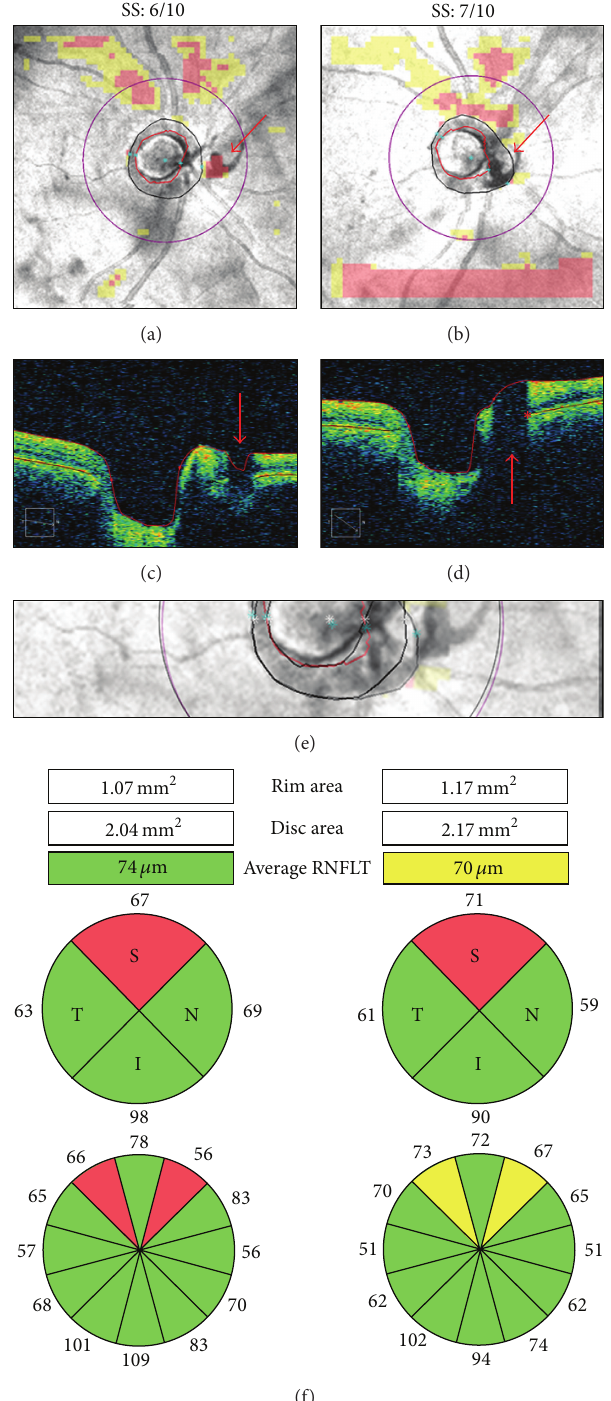
Figure 3: Floater overlying the optic disc region. Cirrus HD-OCT RNFL deviation maps ((a)-(b)), OCT tomograms ((c)-(d)), realigned en- face images (e), and printout results (f) from two right optic disc scans collected on the same day. In the first scan, the floater was located between the optic disc and the scan circle ((a) and (c), arrow). In the second scan, it was automatically included in the optic disc area ((b) and (d), arrow). The nasal margin of the floater was mistakenly interpreted as the optic nerve head neural canal opening ((d) asterisk), leading to increased rim and disc areas (f) and to inferonasal displacement of the optic disc center and the scan circle ((e) purple scan circle). Note the retinal nerve fiber layer thickening in the superotemporal clock hours, closer to the optic disc margin, and the corresponding thinning of the inferonasal clock hours, moved further away from the optic disc. SS: signal